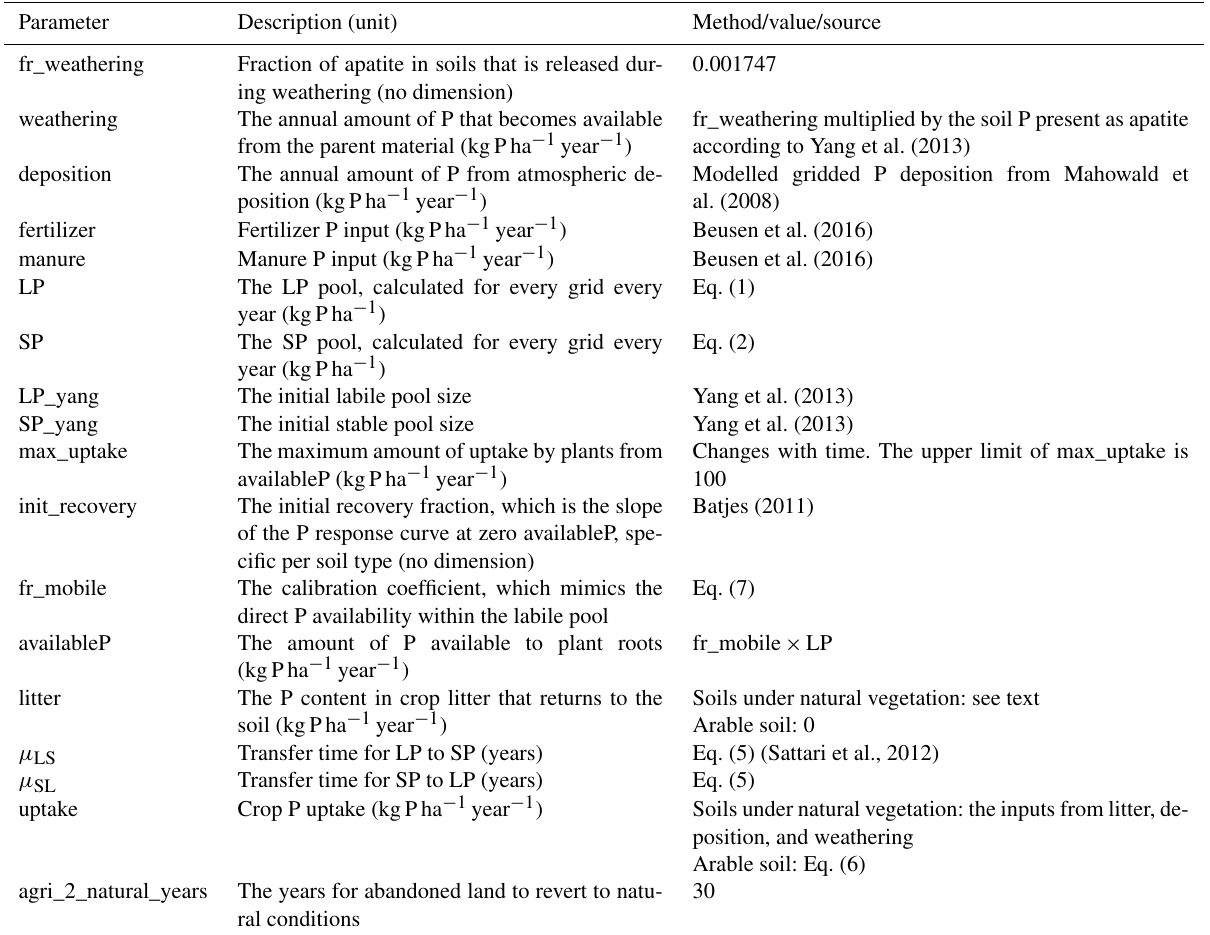
Table 2. Model parameters of